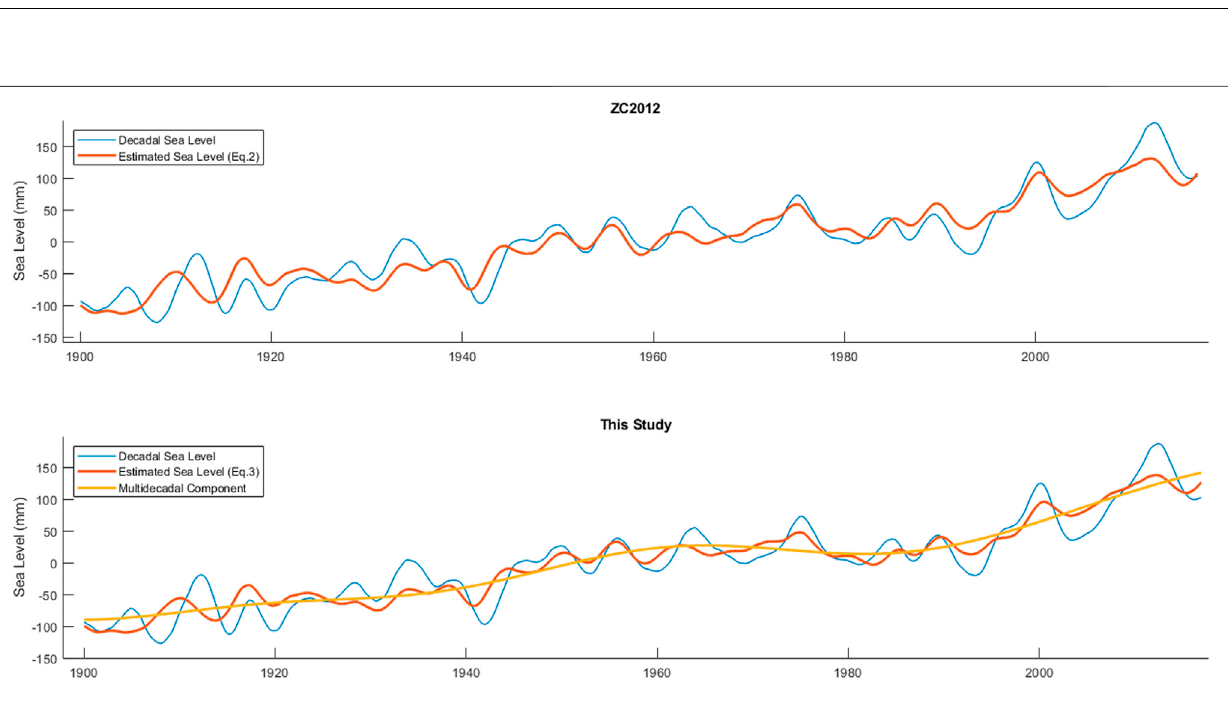
Frontiers in Earth Science |